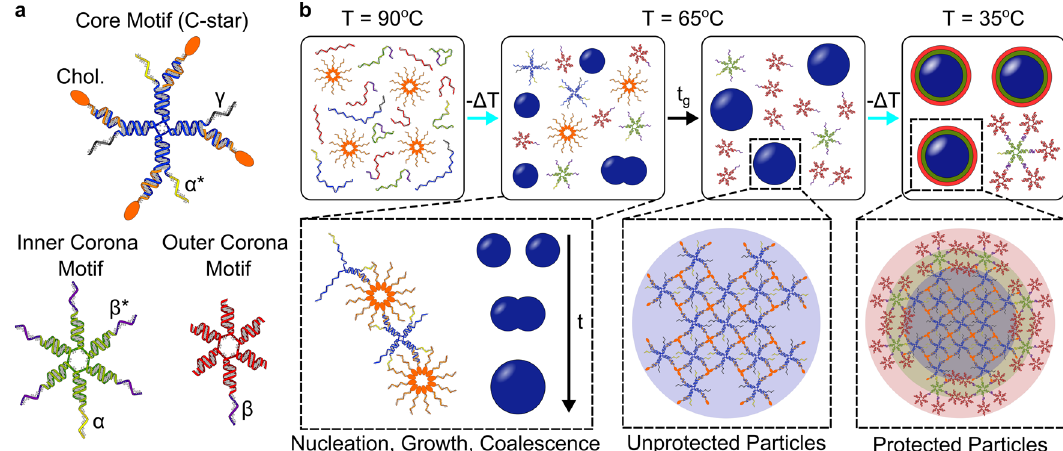
Fig. 1 Design and assembly of particle-forming DNA nanostructures. a DNA nanostars used in the assembly of stable, size-controlled particles. Core motifs (C-stars) assemble from four different strands forming the central junction (blue) and four identical cholesterol-functionalized oligonucleotides (orange). Inner corona motifs (green) and outer corona motifs (red) each self-assemble from six different oligonucleotides. Inner corona motifs bind to the core motifs through α − α * overhangs, while outer corona motifs bind to inner corona motifs through domains β − β * . In the tested design, domain γ is a non- interacting poly-T domain, which could however be replaced with a functional moiety or aptamer useful for anchoring molecular cargoes without impacting C-star self-assembly, as demonstrated in ref. 35 . b Particle assembly pathway. All DNA strands are mixed in stoichiometric ratios. At high temperatures ( T = 90 ∘ C) cholesterol-functionalized strands form micelles while the remaining oligonucleotides freely diffuse in solution. Upon fast quenching to T = 65 ∘ C, C-stars nucleate and grow as previously reported 35 – 37 , leading to the formation of amphiphilic DNA particles whose size depends on the incubation (or growth) time t g at T = 65 ∘ C. At this stage, individual corona motifs assemble but remain detached from the particles. When rapidly cooled down to T = 35 ∘ C, corona motifs coat the particle with a two-layer hydrophilic shell, which offers steric stabilization and prevents further